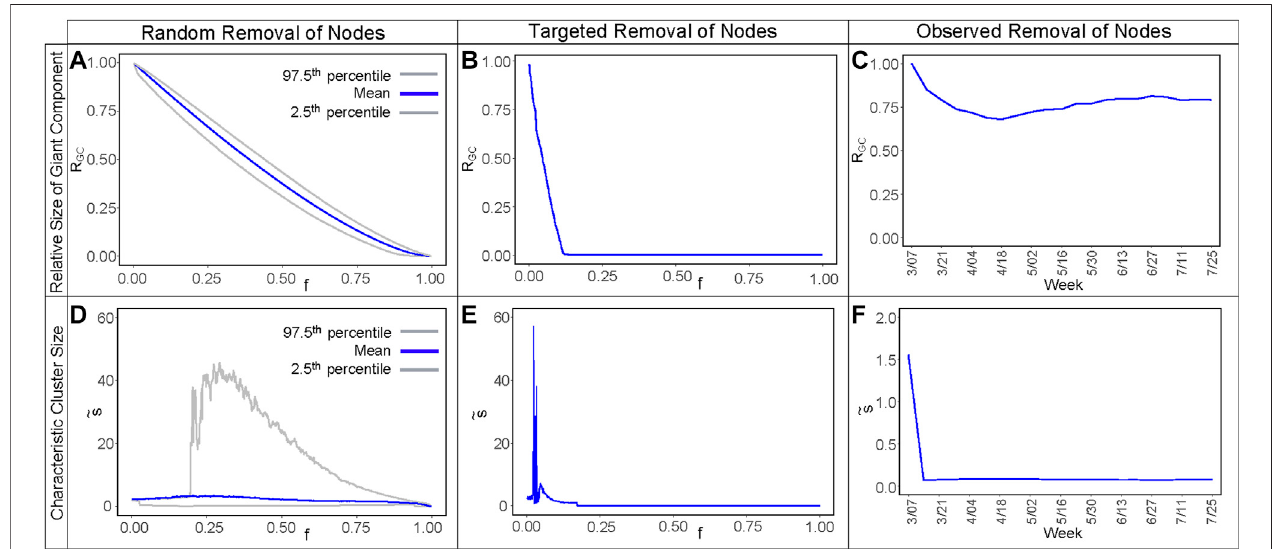
FIGURE 3 | Network Response to Failure and Attack. (A), (B), (D), (E) illustrate the size of the largest component and characteristic cluster size as percolation is conducted on the network of fl ights on the week ending April 25, the week with the lowest observed number of fl ights. (A) and (D) correspond to 10,000 trials of the random removal of nodes, i.e., random error. (B) and (E) correspond to the removal of nodes by decreasing unweighted degree. (A) , (B) , (D) , (E) are plotted against parameter f , the fraction of nodes that have been removed. (C) and (F) correspond to the case in which nodes are removed and added as observed during the pandemic. (A) – (C) show the relative size of the largest component R GC ( f ) (cid:2) N GC ( f ) / N GC ( f (cid:2) 0 ) . As nodes are removed randomly, the giant component disintegrates slowly and resembles a step function, but sharply as the highest degree nodes are removed fi rst. (D) – (F) show the characteristic cluster size ~ s (cid:2) (cid:14) s < s calculated according to Onnela et al. (2007). Typically for non-scale-free networks, at some unique critical threshold f c , as nodes are removed randomly, the largest component disintegrates and ~ s sharply increases. (D) shows that as nodes are removed randomly, the network does not disintegrate at any speci fi c threshold, though thenetworkrarelydeterioratesatvaluesof f below0.2.Atvaluesof f below0.2,thenetworkisnottypicallyperturbedenoughtotriggeranymajordeterioration.However, (E) shows that as high-degree nodes are targeted, the network fragments quickly and without recovery.